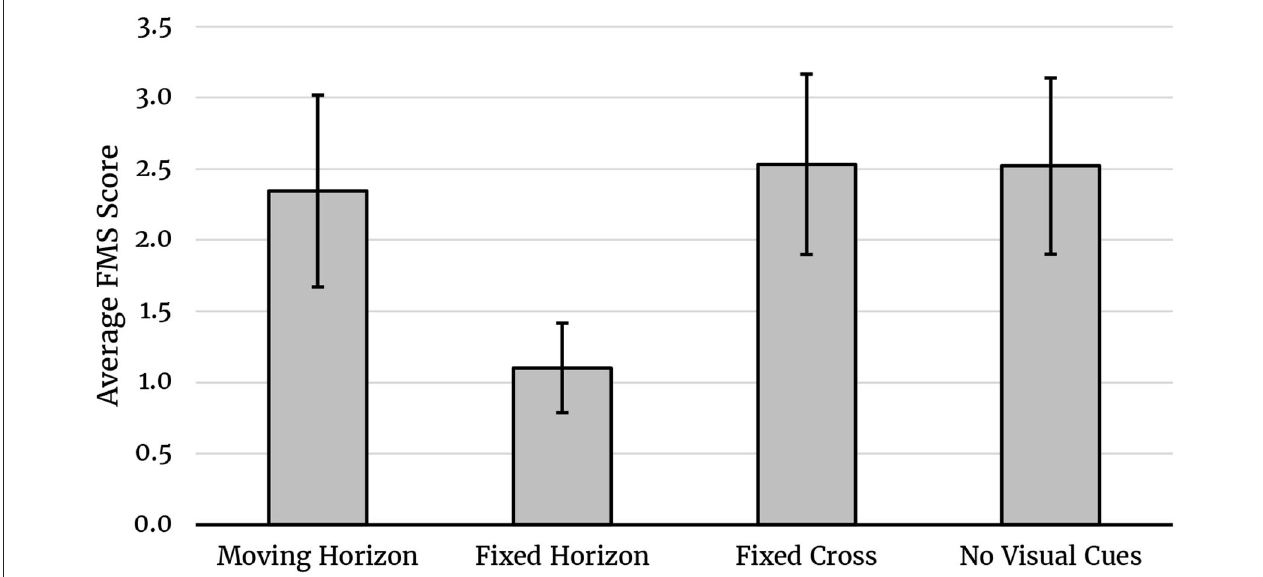
FIGURE 2 | Average FMS scores for each condition. Averages represent the geometric mean. Error bars indicate the SEM.